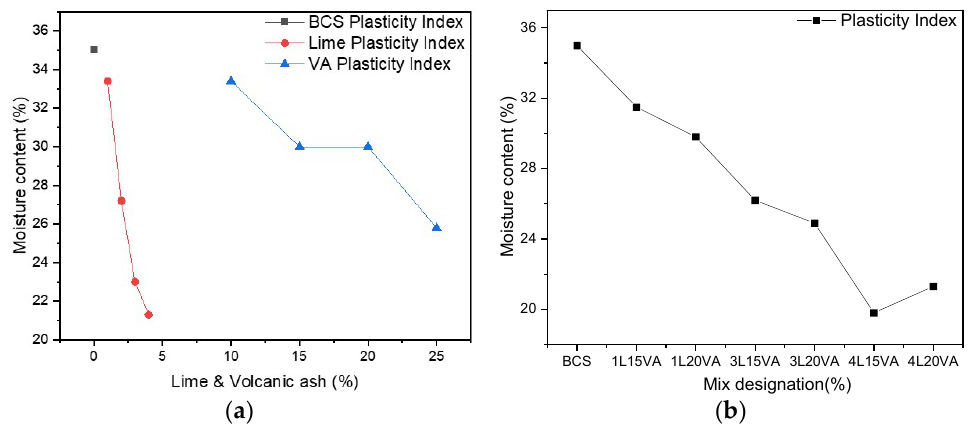
Figure 5. Effects of ( a ) lime and VA and ( b ) Lime–VA combined stabilizer on the plasticity of BCS.